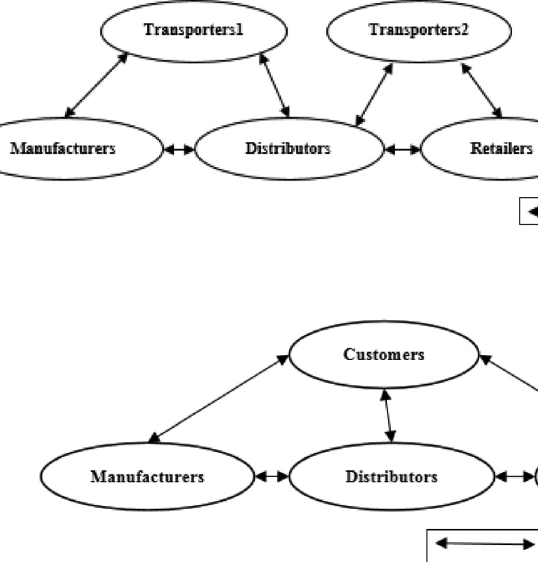
Figure 6. A simple